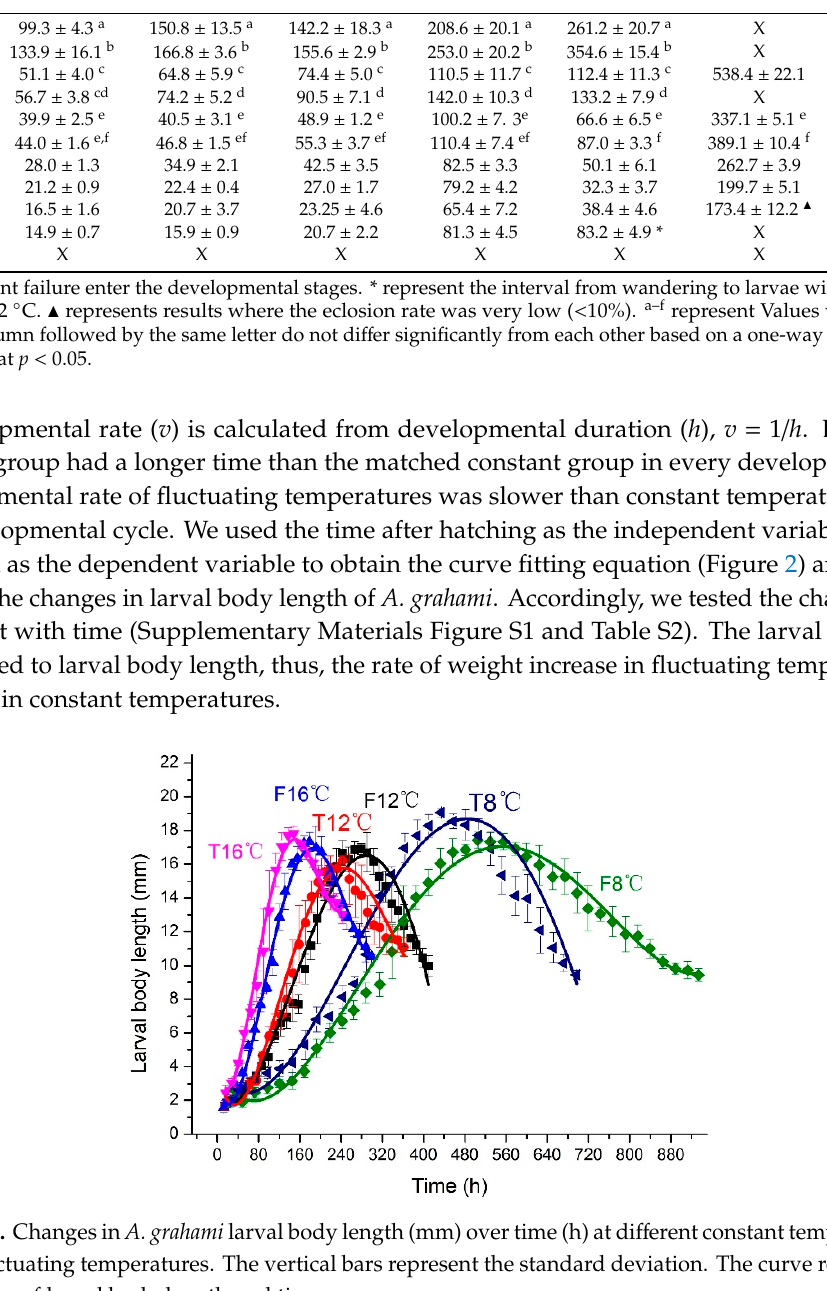
Table 1. Mean (±SD) developmental duration of A. grahami at constant and fluctuating temperatures.